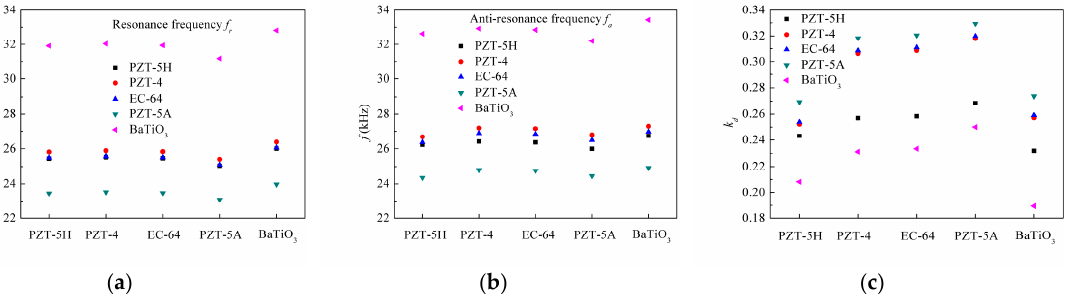
Figure 10. Electromechanical characteristics: ( a ) resonance frequency f r ; ( b ) anti-resonance frequency f a ; ( c ) electromechanical coupling factor k d versus piezoceramic material types.